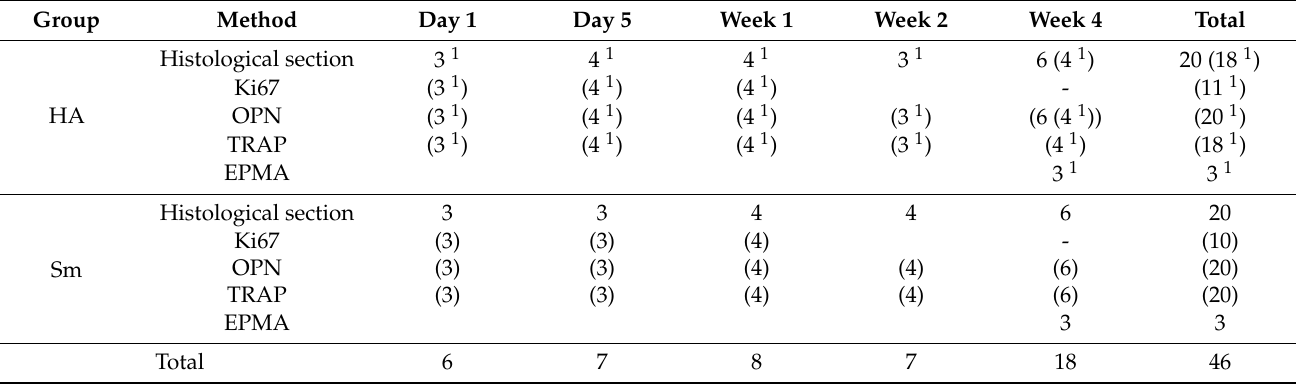
Table 1. Number of animals for histological and immunohistochemical analyses for Ki67 and OPN and TRAP